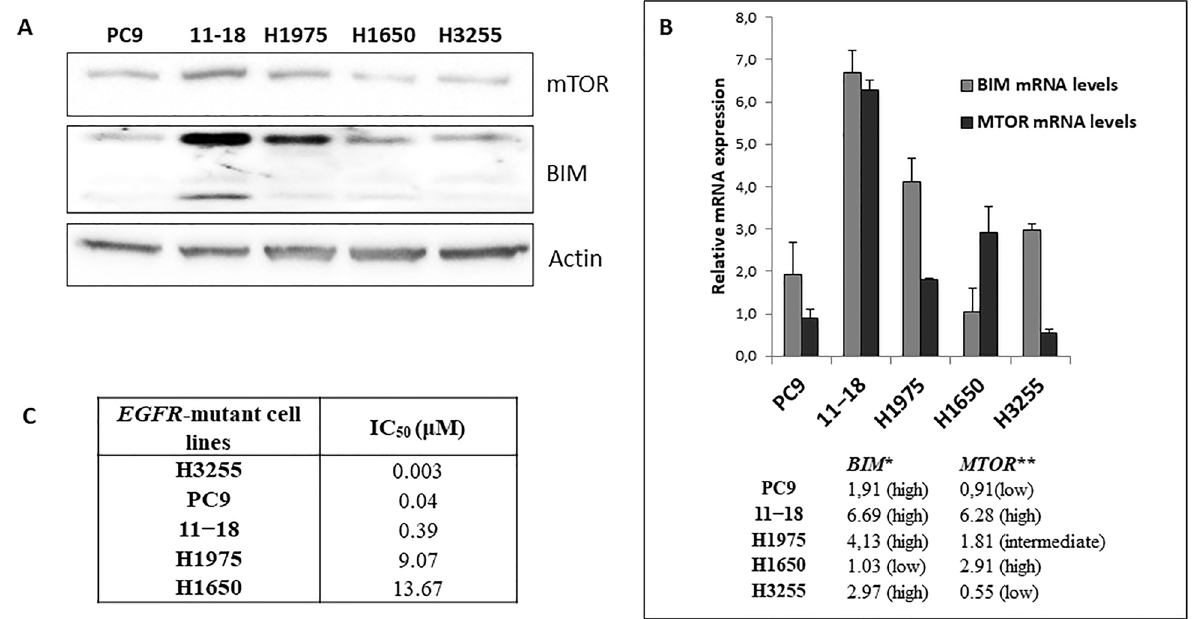
Figure 3. The IC 50 values for gefitinib in EGFR -mutant lung adenocarcinoma cell lines are associated with basal BIM and mTOR expression (protein or mRNA). ( a ) mTOR and BIM expression in EGFR -mutant lung adenocarcinoma cell lines. Lysates were prepared and run on gels for western blot with specific antibodies. Actin was used as the loading control. Among the three sensitive EGFR -mutant lung adenocarcinoma cell lines, H3255, PC-9 and 11–18, 11–18 is the one with the highest mTOR and BIM protein expression. ( b ) MTOR and BIM mRNA expression in EGFR -mutant lung adenocarcinoma cell lines by qRT-PCR normalized to β-actin. Among the three sensitive EGFR -mutant lung adenocarcinoma cell lines, H3255, PC-9 and 11–18, 11–18 has the highest MTOR and BIM mRNA expression. PC-9, 11–18 and H1975 cells have high BIM mRNA expression. H1650 cells have low BIM mRNA expression. The two gefitinib resistant EGFR -mutant lung adenocarcinoma cell lines, H1975 and H1650, have intermediate and high MTOR mRNA expression levels, respectively. Values are the mean ± standard deviation of triplicate experiments. * BIM low, < 1.83; BIM intermediate, 1.83–2.96; BIM high, > 2.96; MTOR low, < 0.91; ** MTOR intermediate, 0.91–1.97; and MTOR high, > 1.97. Error bars indicate the standard deviation. ( c ) The IC 50 values for gefitinib increase in the three sensitive EGFR -mutant lung adenocarcinoma cell lines, H3255, PC-9 and 11–18, as mTOR expression increases (protein or mRNA). 11–18 are sensitive cells with the highest mTOR expression and IC 50 value for gefitinib 0.39 μM, a concentration more than 100-fold higher compared to H3255 cells that have the lowest mTOR expression and are hypersensitive to gefitinib (IC 50 0.003